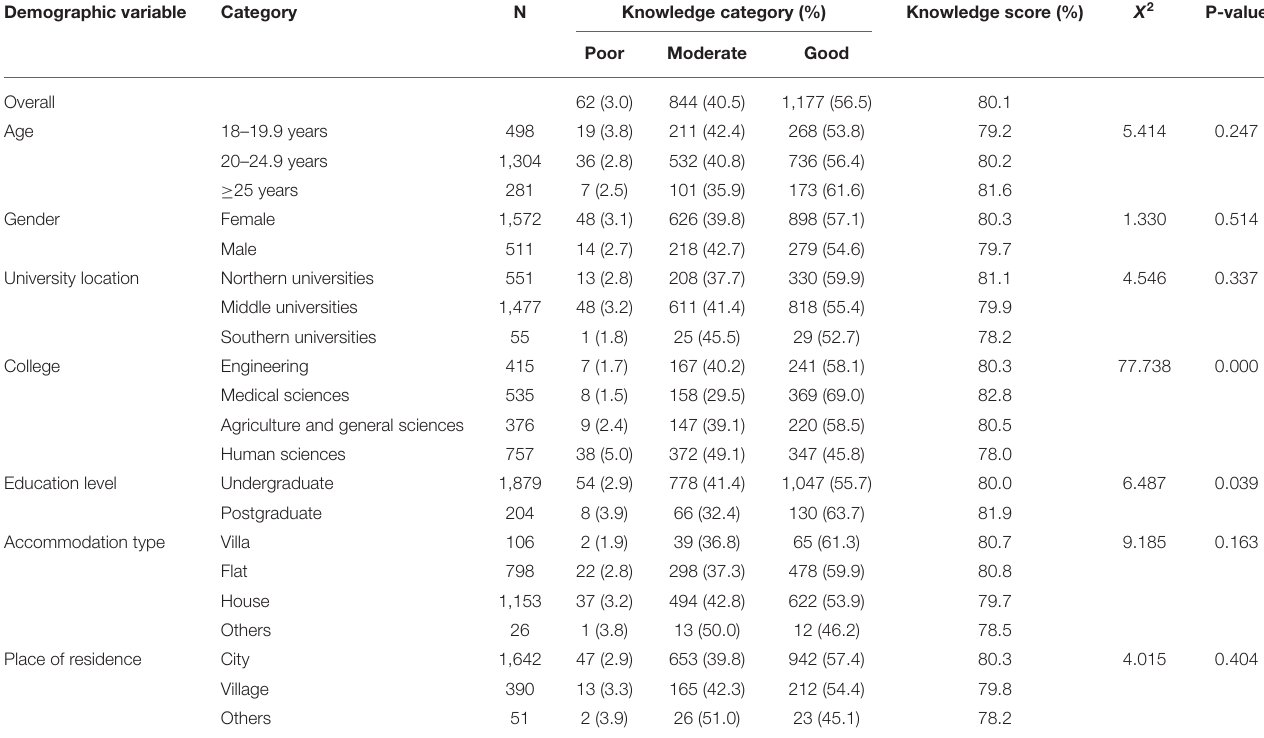
TABLE 1 | Demographic characteristics of university students and knowledge score of COVID-19 among University students in Jordan by socio-demographic variables. Demographic